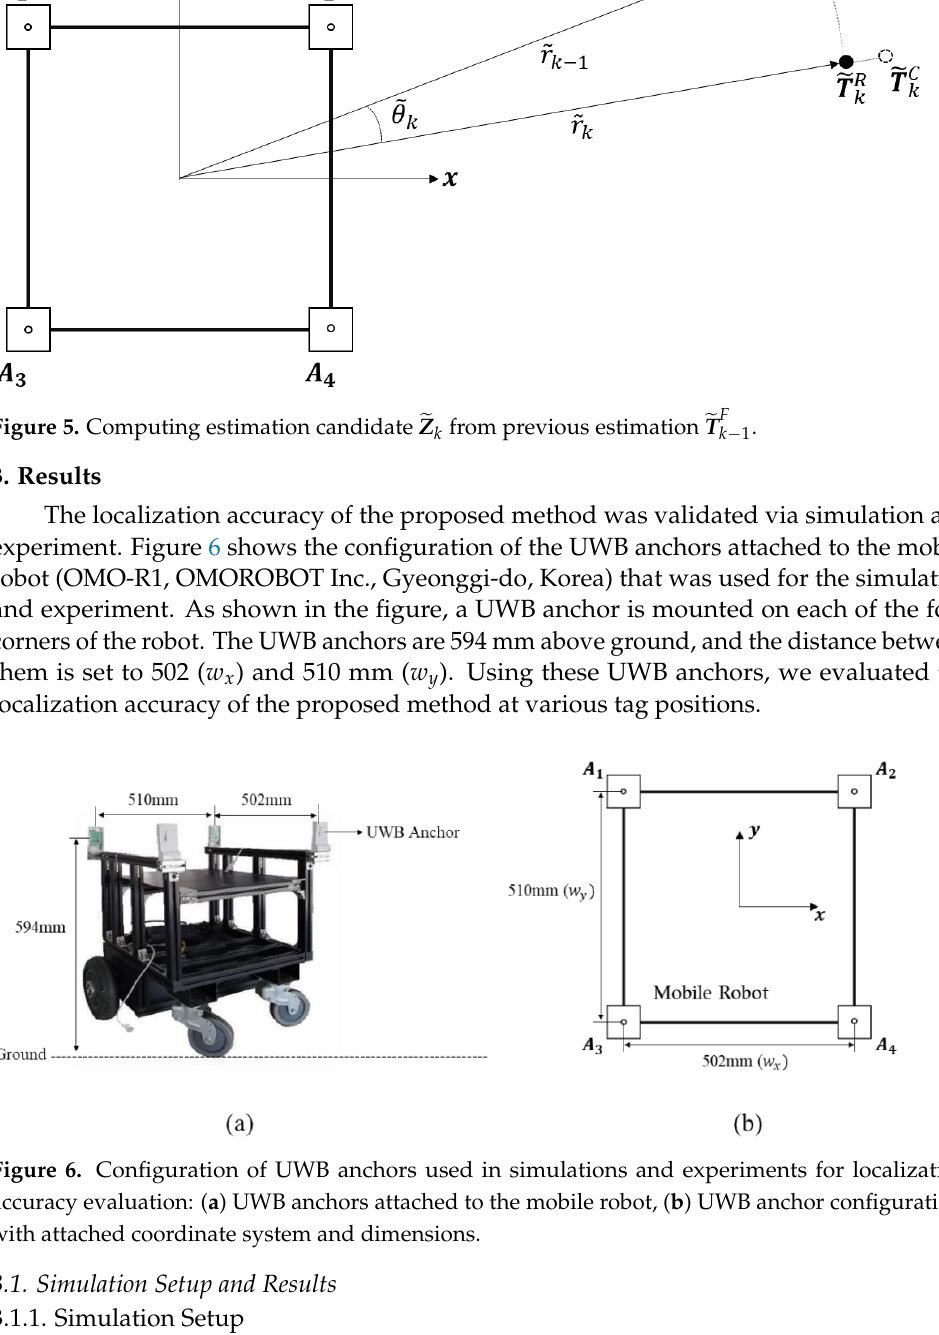
Table 1. Mean and standard deviation of distance measurement used in the simulation.